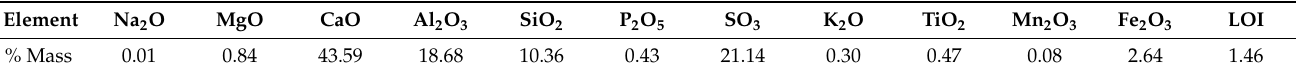
Table 1. Oxide composition of CSA cement.